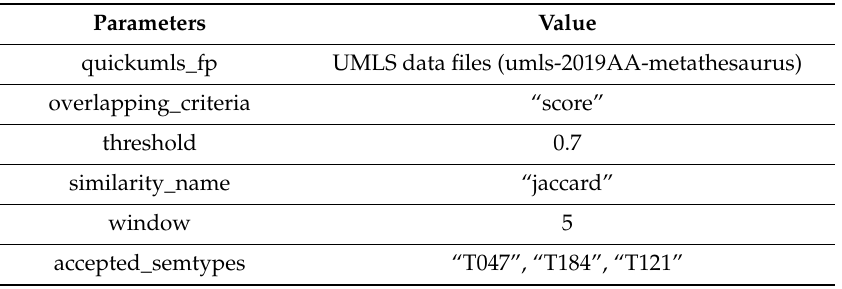
Table 4. Dataset annotation.